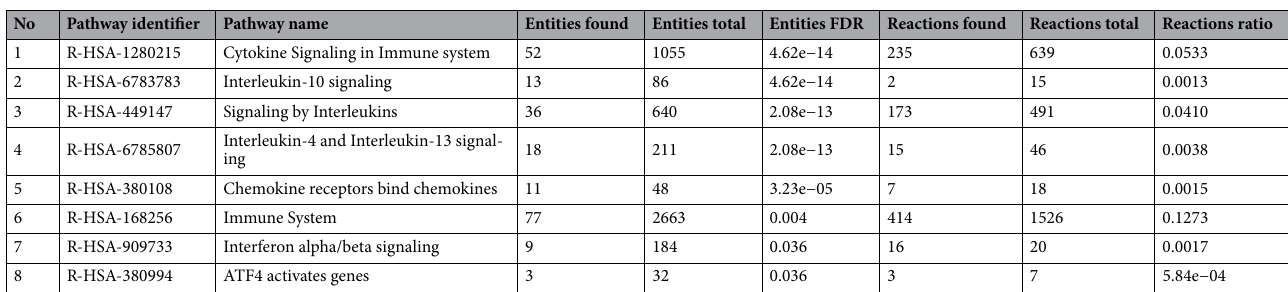
Table 2. DEGs involved in the biological processes, categorized by Reactome server (transcriptomes induced after exposure of hBMECs to S. pneumoniae